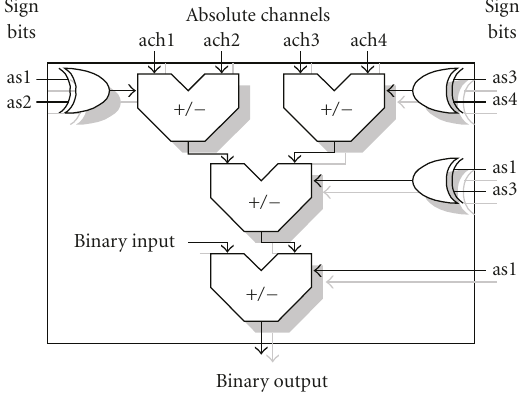
Figure 4: Two-digit one-bit sign accumulation component.